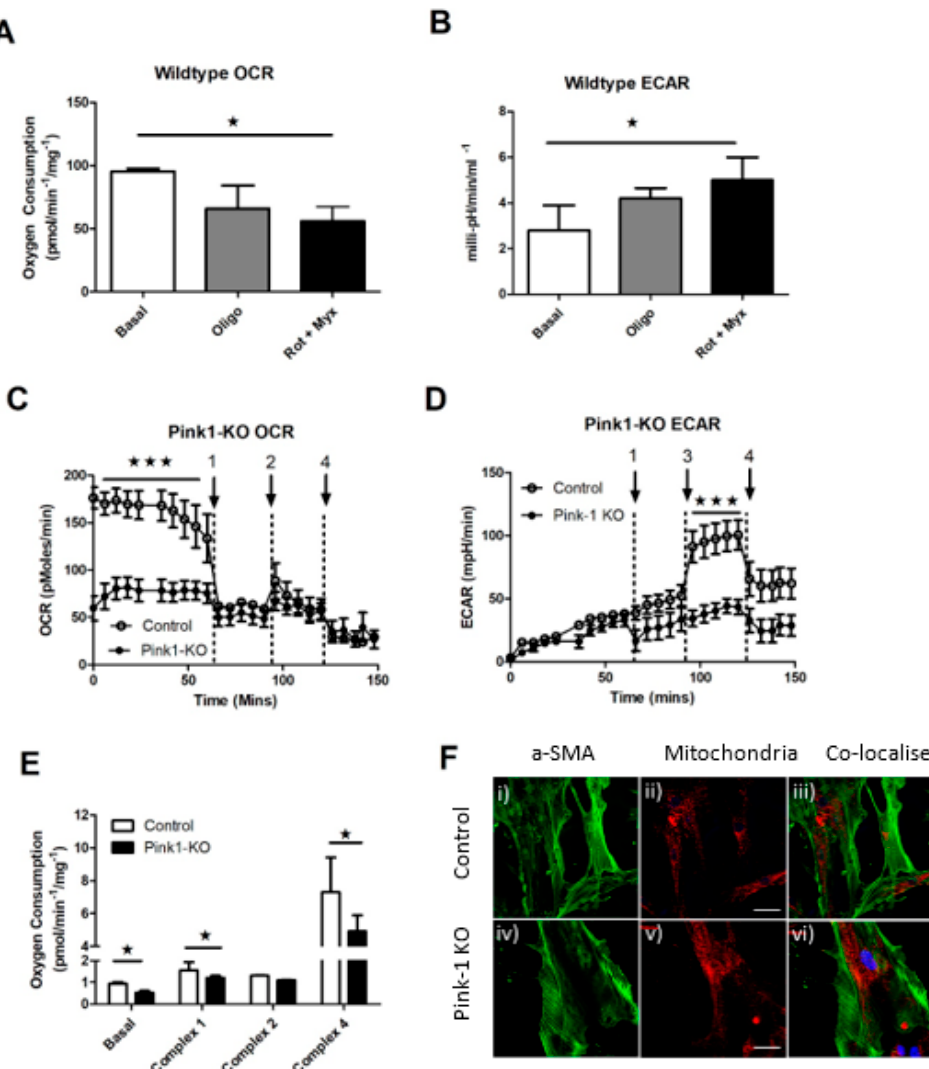
Figure 5. Pink1-KO ApoE − / − mice have reduced respiratory capacity and ability to switch energetics to glycolysis compared to wild type. ( A ) Inhibition of mitochondrial respiration in Pink1+/+ wild-type VSMC retains a switching effect by ( B ) concomitant energetic switching by upregulation of glycolysis (ECAR). ( C ) In contrast, Pink1-KO cells have a decreased basal oxygen consumption rate (OCR) and sensitivity to inhibition of mitochondrial respiratory chain inhibitors; oligomy- cin (Arrow 1), uncoupler FCCP (Arrow 2) and rotenone and mxyothiazol (Arrow 4). ( D ) Loss of compensatory switch to glycolysis after oligomycin (Arrow 1) glucose bolus (Arrow 3) and 2-deoxy-glucose inhibitor 2-DG (Arrow 4) (n = 5). ( E ) Reduced mitochondrial oxygen consumption in Pink1 KO aortic tissue after high-fat diet both basally and specifically at complex I- and IV-dependent respiration. ( F ) Confocal images of mitochondrial VSMC α -SMA (green) (i–iv), mitochon- drial abundance (red) (ii–v) with nuclear dapi (blue) co-localised combined channels to compare gross mitochondrial mass abundance between wild-type (Pink1+/+), control (upper) and Pink1 KO (lower) (n = 12) (scale 20 µm). One-way ANOVA with Dunnett’s post hoc test (n = 5), * p ≤ 0.05, *** p ≤ 0.001 vs. control.